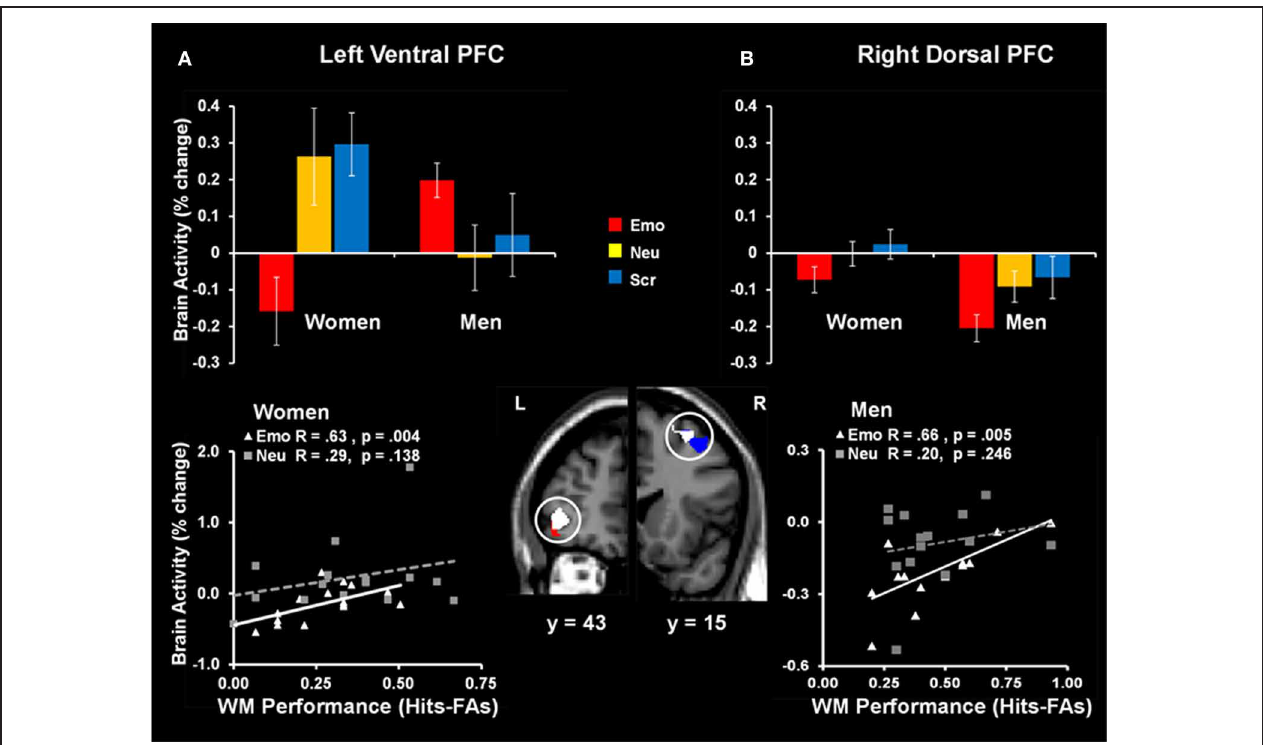
to emotional distraction between women and men: men > women (red cluster) and women > men (blue cluster). The white activation maps illustrate the positive correlation between brain activity in response to emotional stimuli and WM performance in women (left ventral PFC) and men (right dorsal PFC). Scatterplots depicting these co-variations are presented in the bottom panels. The activation maps are superimposed on a high-resolution brain image displayed in coronal view (with y indicating the Talairach coordinates on the anterior- posterior axis of the brain). Error bars represent standard errors of means. Emo, Emotional distracters; Neu, Neutral distracters; Scr, Scrambled distracters; L, left; R, Right. Reproduced from Iordan et al. (2013a), with